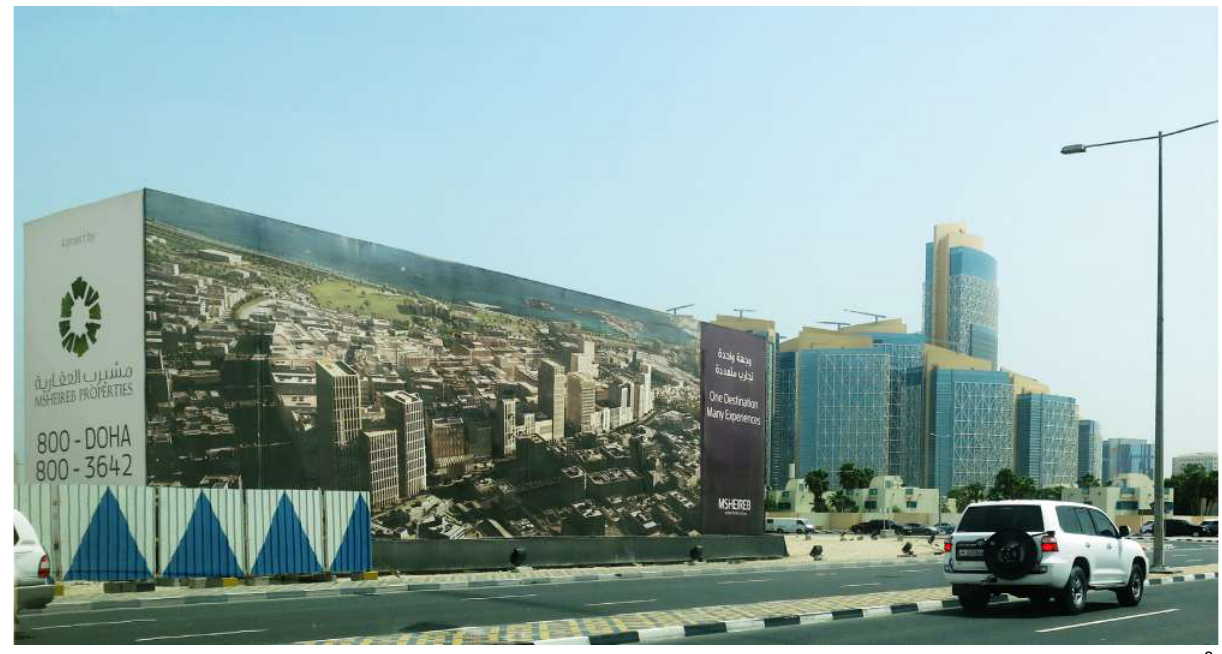
Fig. 8 QDP. Qatar Petroleum District and billboard for Msheireb. The representation of the ‘real’ in one mega-development flows together with ‘real’ in another (Source: Peter Chomowicz,